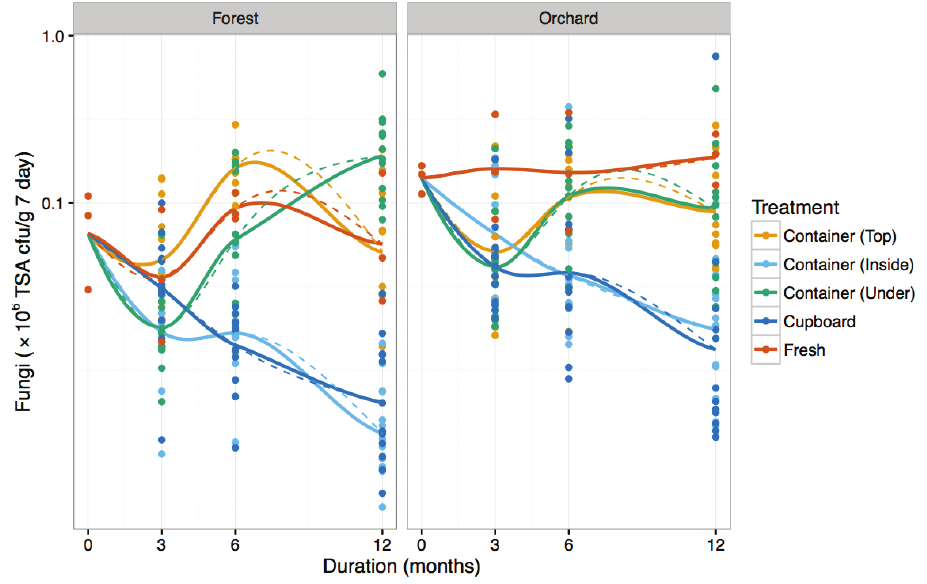
Figure 3. Scatterplot of mean fungus counts (cfu/g) at 0, 3, 6 and 12 months measured in soil recovered from on, in and under four sea containers and inside four cupboards. Solid lines show the smoothed means and dashed lines predictions from the preferred